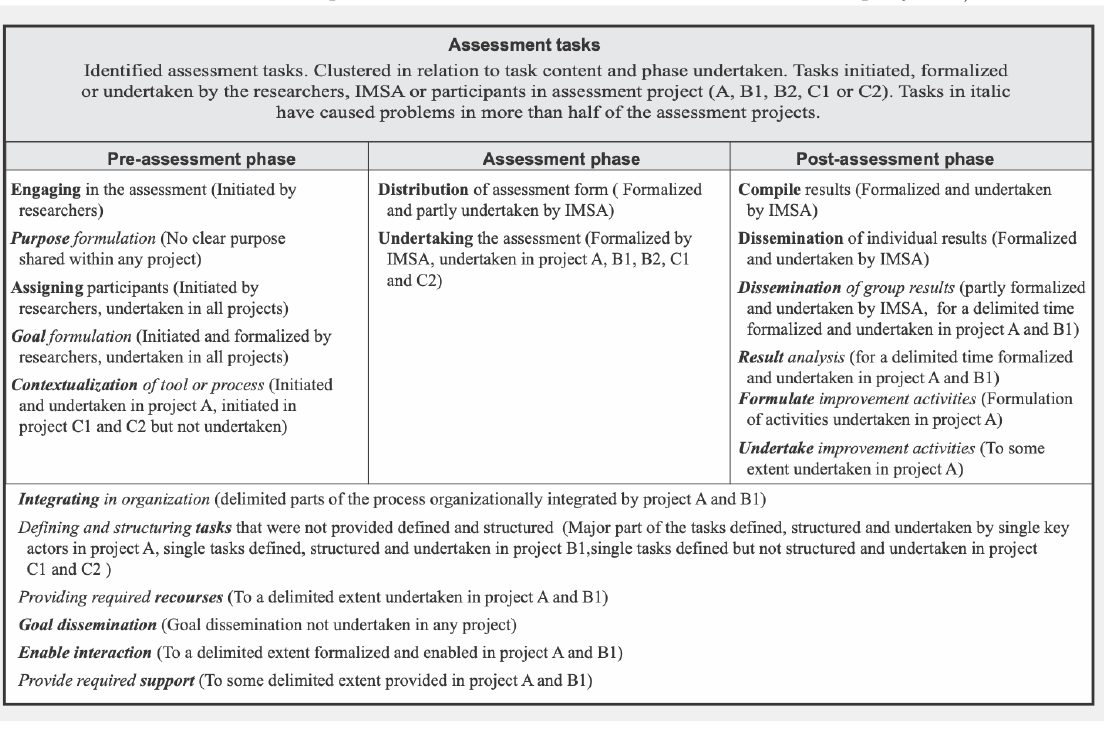
Table 2. Identified assessment tasks, clustered in relation to task content and phase undertaken (Tasks in italics have caused problems in three or more of the assessment